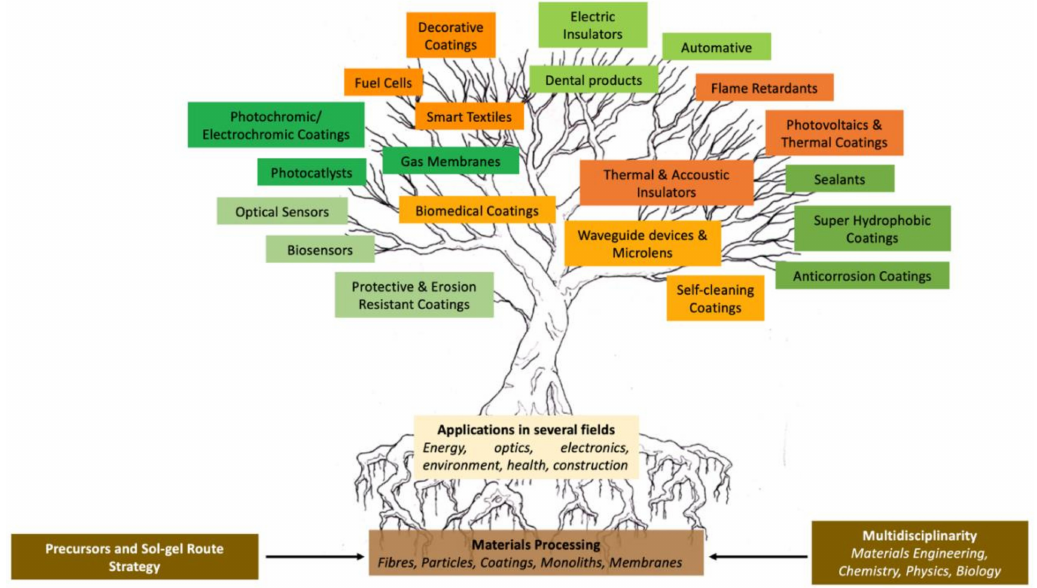
Figure 2. Arborescence representation of OIH materials applications. Adapted from